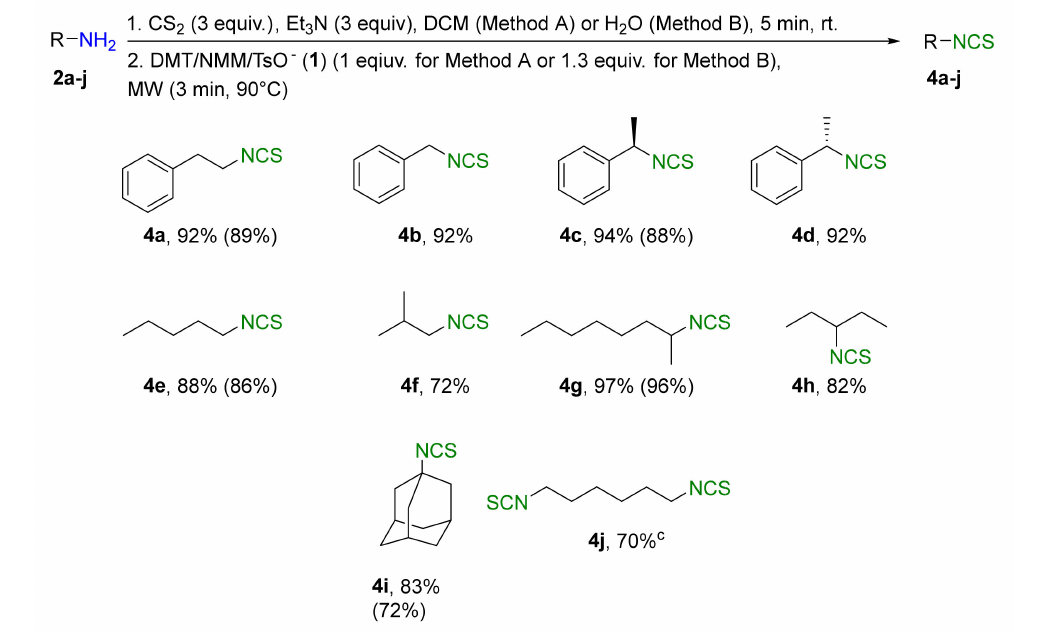
Figure 3. Scope of aliphatic isothiocyanates 4a –j a,b . a - Method A : conditions: amine 2a – j (2 mmol), Et 3 N (3 equiv., 6 mmol), CS 2 (3 equiv., 6 mmol), DCM (3 mL), first step 5 min, rt, then DMT/NMM/TsO − ( 1 ) (2 mmol, 1 equiv.); MW irradiation in standard mode 3 min, 90 ◦ C. Yield of products isolated after flash chromatography (hexane). Method B : conditions: amine 2a , 2c , 2e , 2g ,